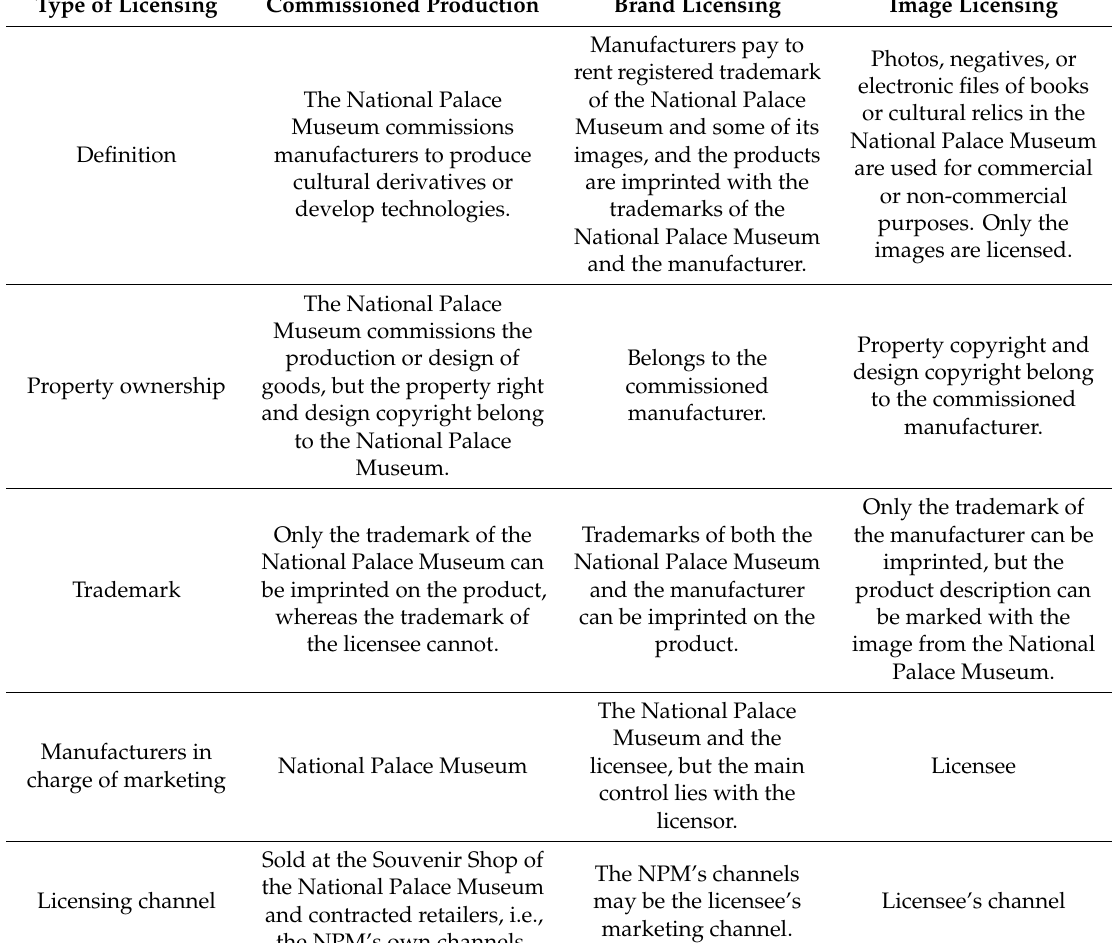
Table 2. Types of art licensing in the National Palace